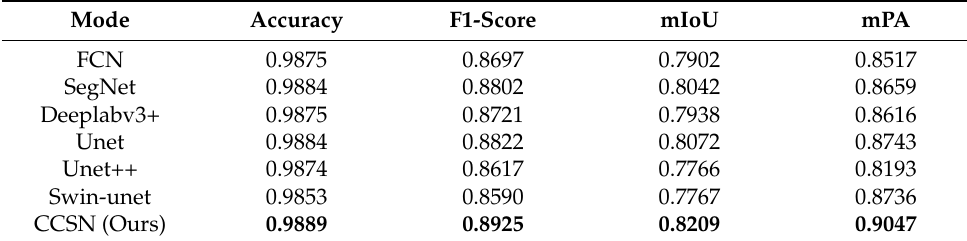
Table 9. Results of different networks by BCL.